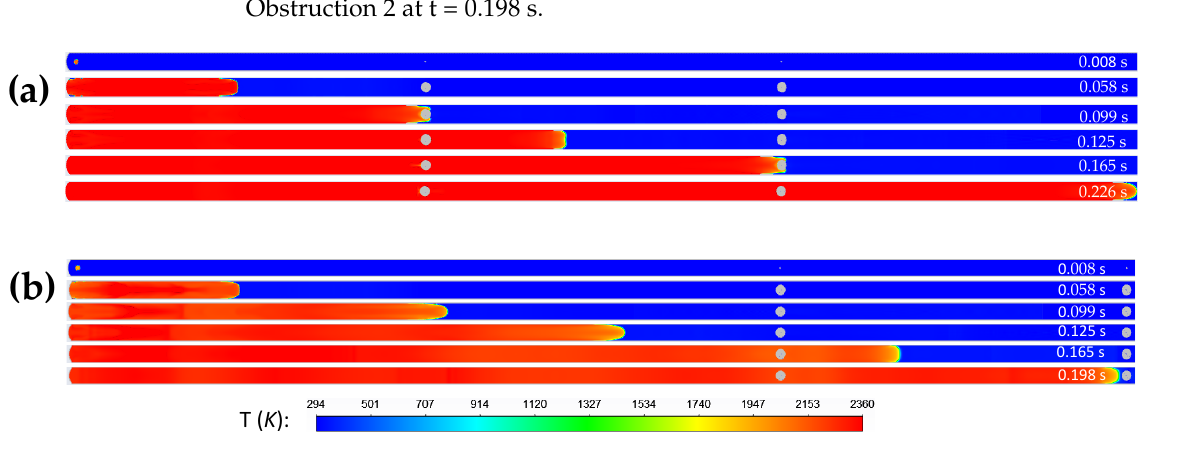
Figure 14. Flame propagation after explosion occurs for different scenarios where two obstructions are installed with 50% inflation at locations ( a ) x =10 m and x =20 m and ( b ) x = 20 m and x =30 m. In both cases, the time required for the flame to reach the tube end is longer than that Error! Reference source not found. shows the temperature profiles for the two sce- narios where two obstructions are installed at two different locations. It is evident that the flame propagates faster in the scenario where two obstructions are installed towards the tube open end, i.e., at locations x =20 m and x = 30 m; this is more pronounced in the late stage when the flame propagates further way from the ignition point. As discussed above, the presence obstruction accelerates the upstream flow, but decelerates the downstream flow. Therefore, the flame propagation speed is higher when the obstructions are installed closer to the tube open end, as it leads to more time for the acceleration. However, the flame takes the shortest time to propagate out of the empty tube (as seen at t = 0.19 s) due to the presence of the obstruction at the tube open end.